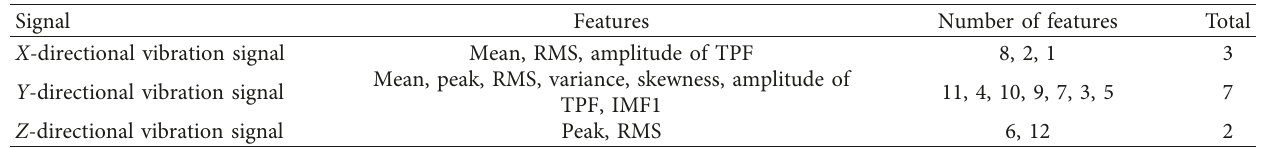
Table 6: The detailed information of selected main